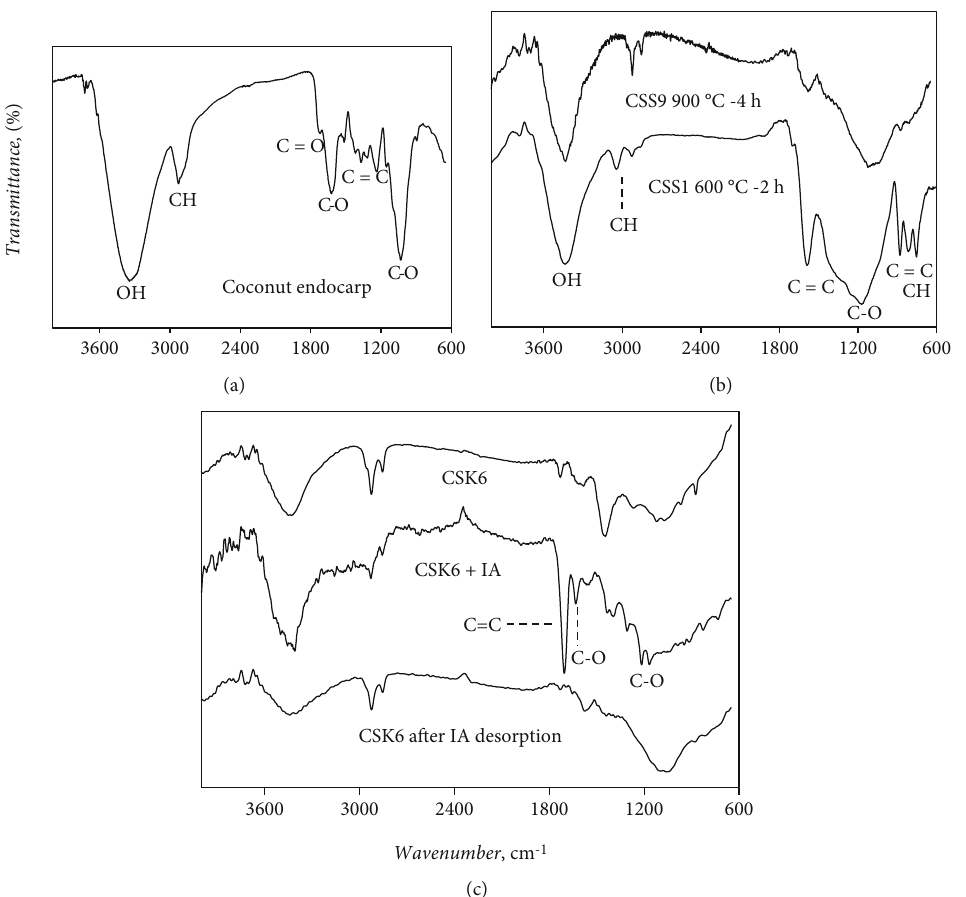
Figure 2: FTIR spectra of coconut shell biomass, CSS samples Nos. 1 and 9 (CSS1 and CSS9), and CSK sample No. 6 (CSK6) used in the itaconic acid